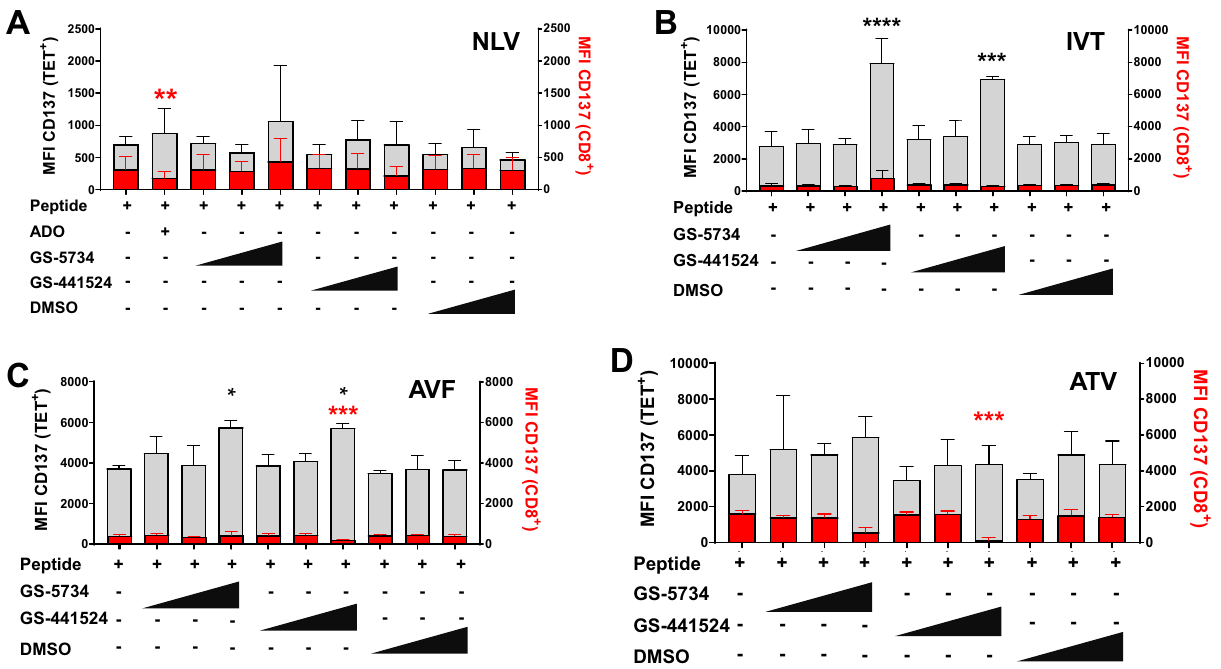
Figure 2. Effect of drug on T cell activation. ( A ) HLA-A*02:01 donor #1 PBMCs and ( B – D ) HLA-A*11:01 donor #3 PBMCs were treated and assayed on day 7 as described in Fig. 1. Grey bars represent CD137 MFI in CD8 + tetramer positive T cells, red bars represent CD137 MFI in CD8 + tetramer negative T cells (bystander). ADO was omitted from donor #3 data due to low number of tetramer positive T cells. NLV, IVT, AVF and ATV represents NLVPMVATV, IVTDFSVIK, AVFDRKSDAK, and ATVQGQNLK, respectively. Data